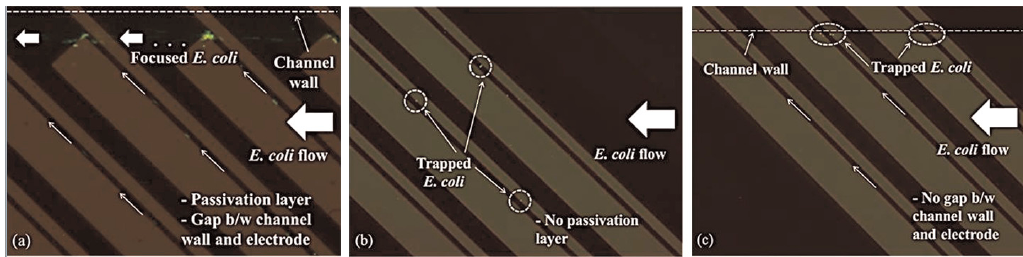
Figure 5. Characterization of pDEP-based E. coli focusing. ( a ) The electrode is covered by a passivation layer. Cells flow through the electrode edge and are liberated at the end of the electrode; ( b ) Cells are not flowing. They persist trapped on the electrode, which is not covered by a passivation layer; ( c ) Cells flow along the electrode but not liberated from it (reproduced with permission from [30]).